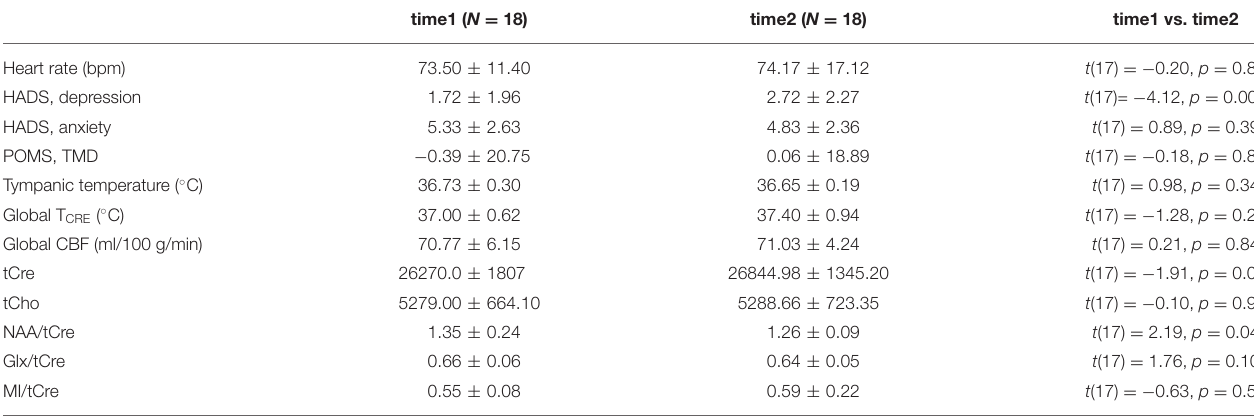
TABLE 1 | Descriptive statistics for clinical and imaging-derived measures of temperature, blood flow, average metabolite values (in institutional units), and metabolite